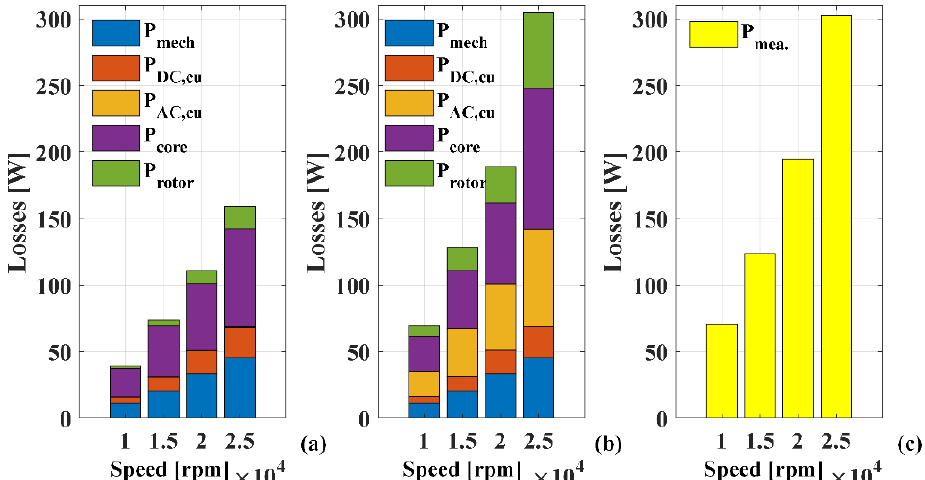
Figure 16. Comparison of analysis and experimental results according to speed and loss components: ( a ) analysis with sinusoidal current, ( b ) analysis with PWM current, and ( c ) experiment. Table 5. Comparison of power loss and efficiency results according to operating conditions. Torque Speed (rpm) (N ·